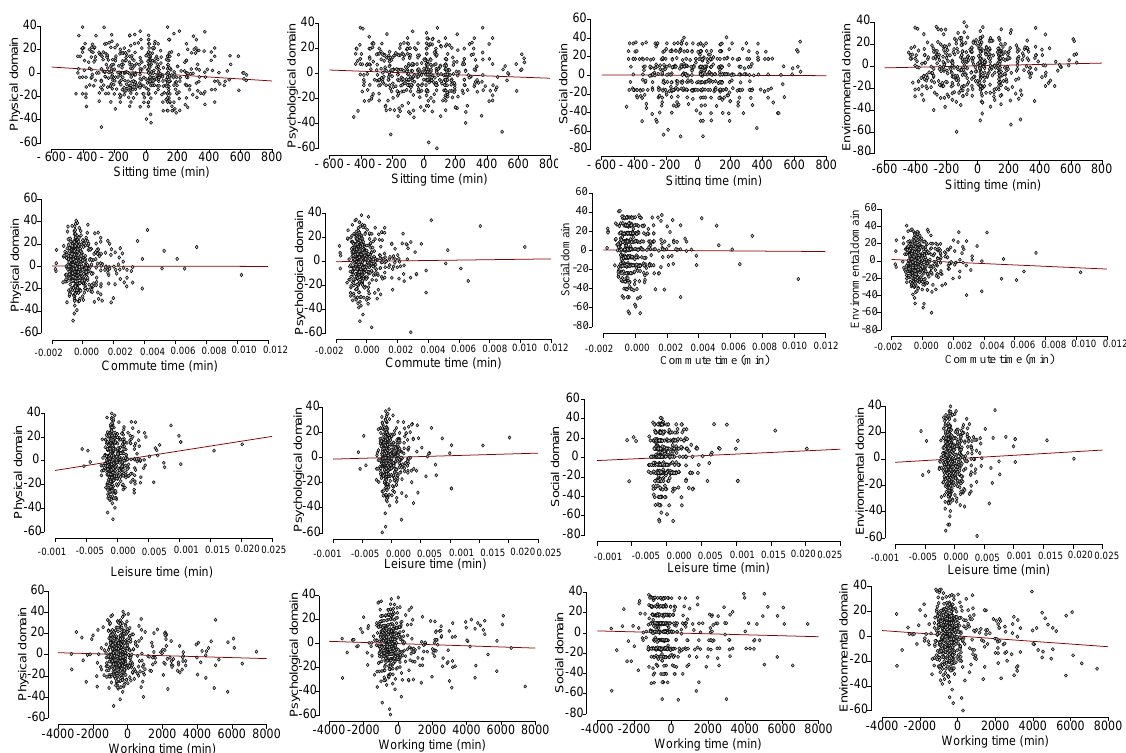
Figure 1. Scatter plots showing the relationship between the sedentary and physical activity dimen- sions (commute, leisure, and work) and quality-of-life